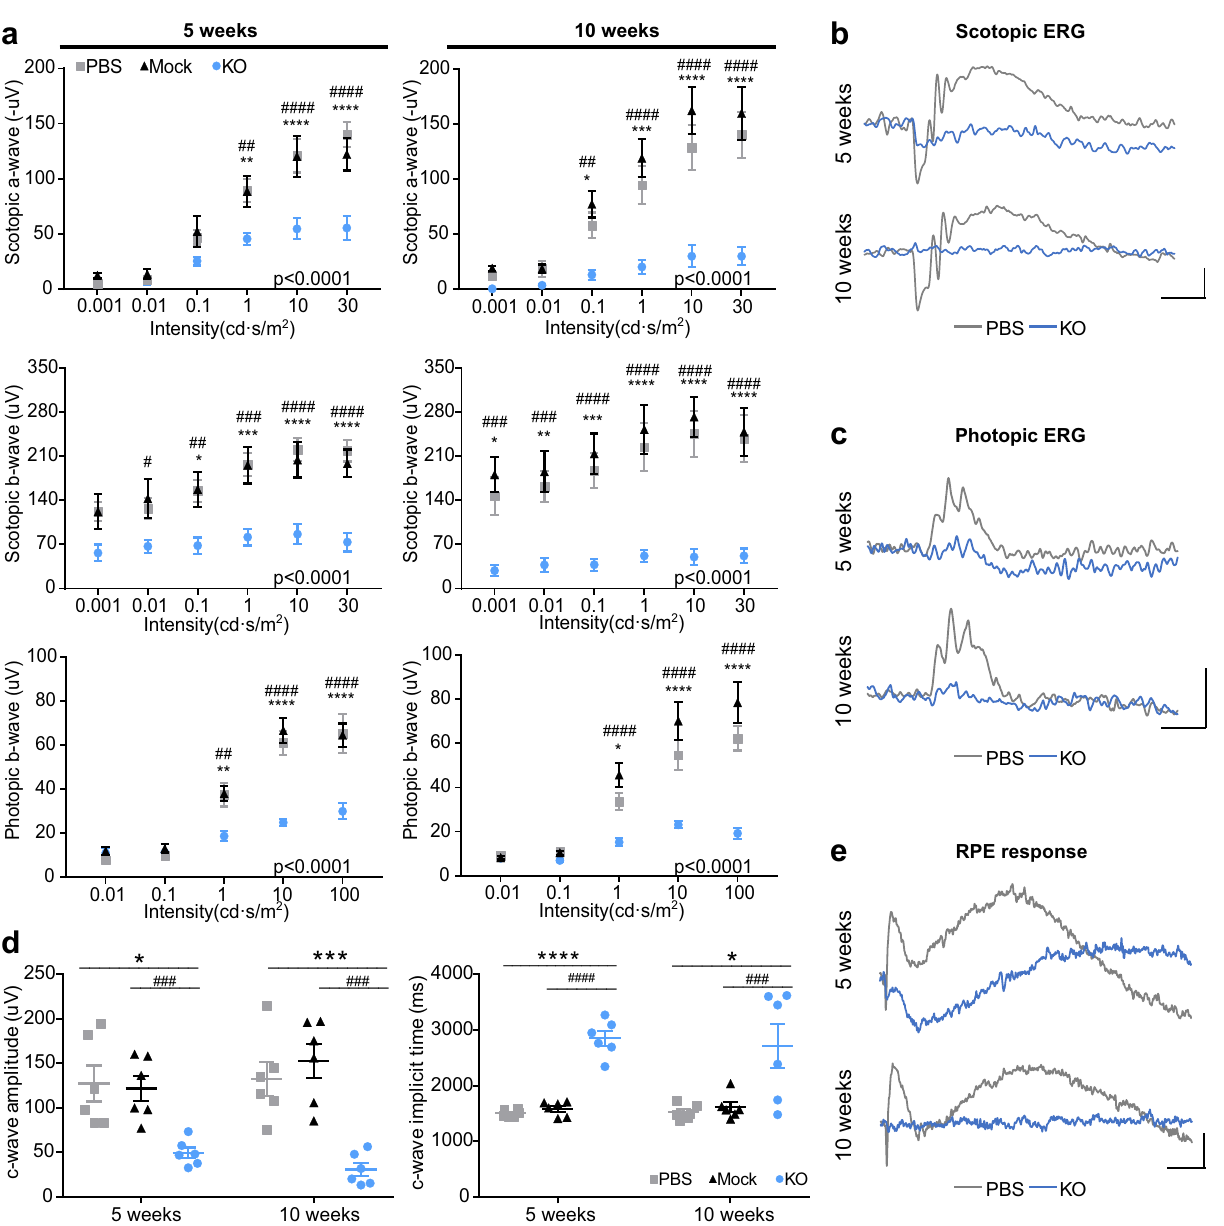
eyes. At 10 weeks (p.i.), ERG responses of KO eyes were further impaired, showing almostnodetectablea-,b-,orc-waves,indicatingadramaticlossofphotoreceptor and RPE function. Data were shown as mean±SEM. The signi fi cance of the overall treatment factor was calculated by two-way ANOVA and shown as P values in the plots.Thesigni fi canceofthetreatmentfactorateach fl ashintensitywascalculated by Sidak multiple comparisons test and marked as * P <.05; ** P <.01; *** P <.001; **** P <.0001. “ * ” shows signi fi cance between KO and PBS groups, and “ # ” shows signi fi cance between KO and mock groups. Data from ERG c-waves were analyzed using a two-tailed unpaired t-test. Source data are provided as a Source Data fi